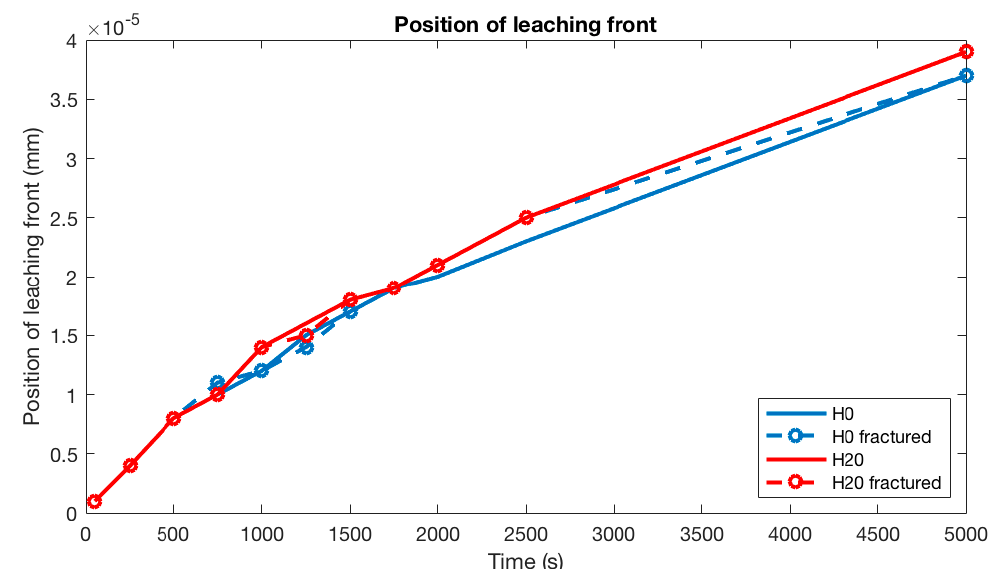
Figure 9. Position of degradation front for the simulated microstructures.